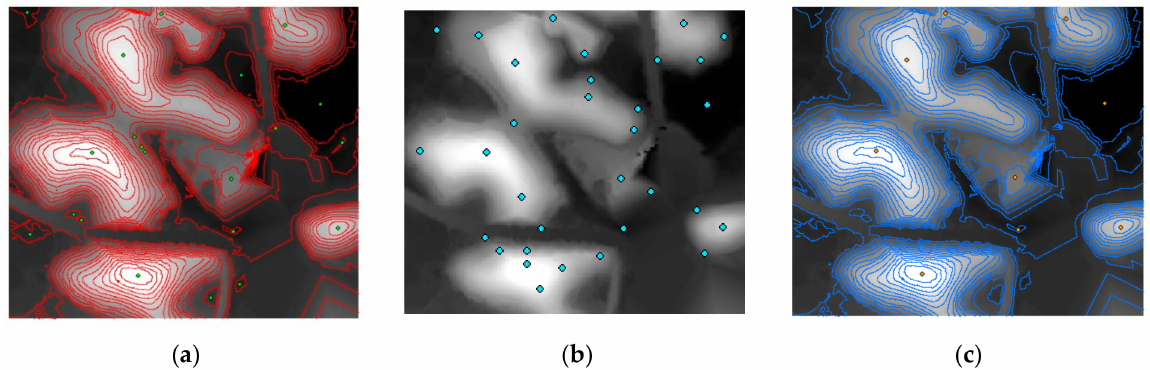
Figure 10. The experimental first dataset distribution map extracted using traditional mountain vertex extraction meth- ods: ( a ) Contour Line Method; ( b ) Neighborhood Analysis Method; and ( c ) Contour line and Neighborhood Analysis Overlay Method.